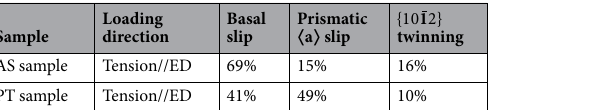
1 {10 2} twinning